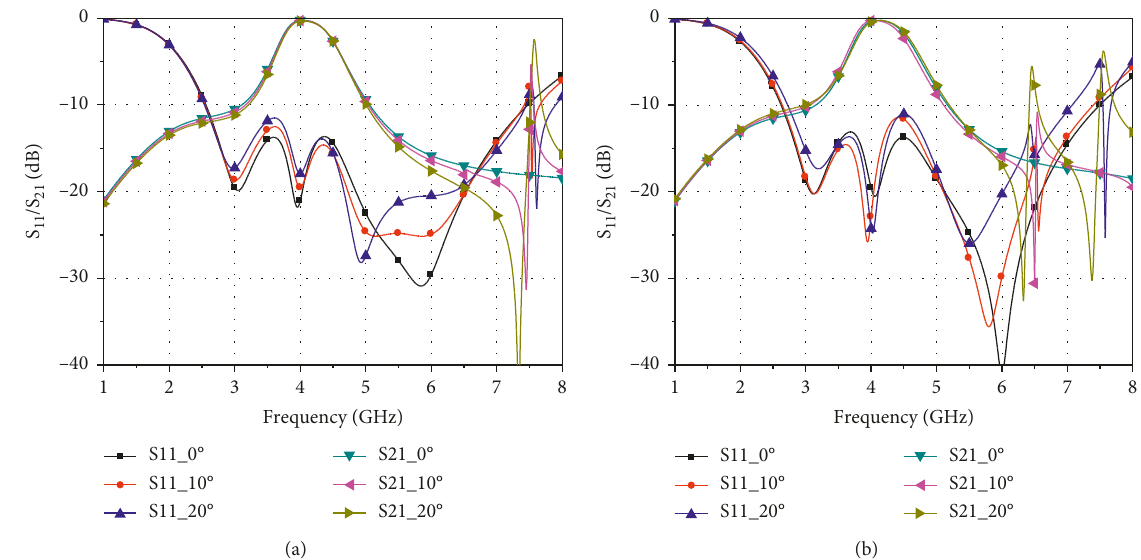
Figure 6: Simulated results of reflection/transmission coefficients of preliminary design under different oblique incidence angles. (a) TE polarization. (b) TM polarization.